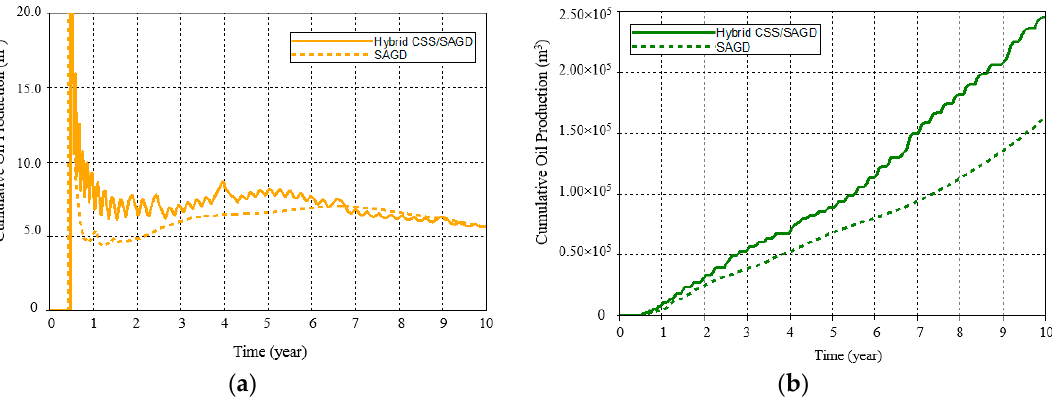
Figure 15. Comparison between the hybrid CSS/SAGD method and conventional SAGD method: ( a ) relationship between cumulative SOR and time for hybrid CSS/SAGD and conventional SAGD processes; ( b ) relationship between cumulative oil production and time for hybrid CSS/SAGD and conventional SAGD processes.